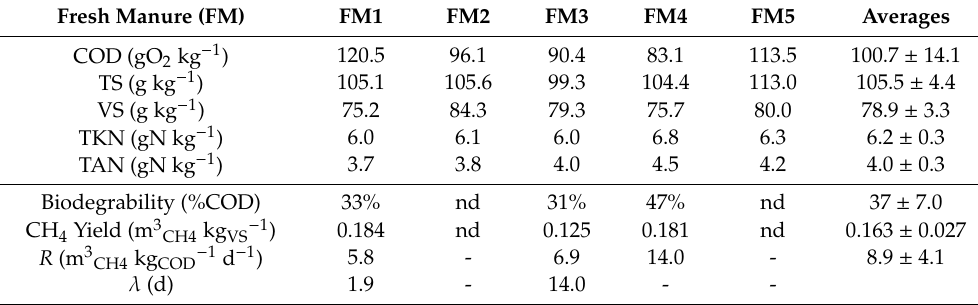
Table 1. Characterization of fresh pig manure. (FM, fresh manure. COD, chemical oxygen demand. TS, VS, total and volatile solids. TKN, TAN, total Kjeldahl and ammonia nitrogen. R , methane production rate. λ , lag phase. Nd, not